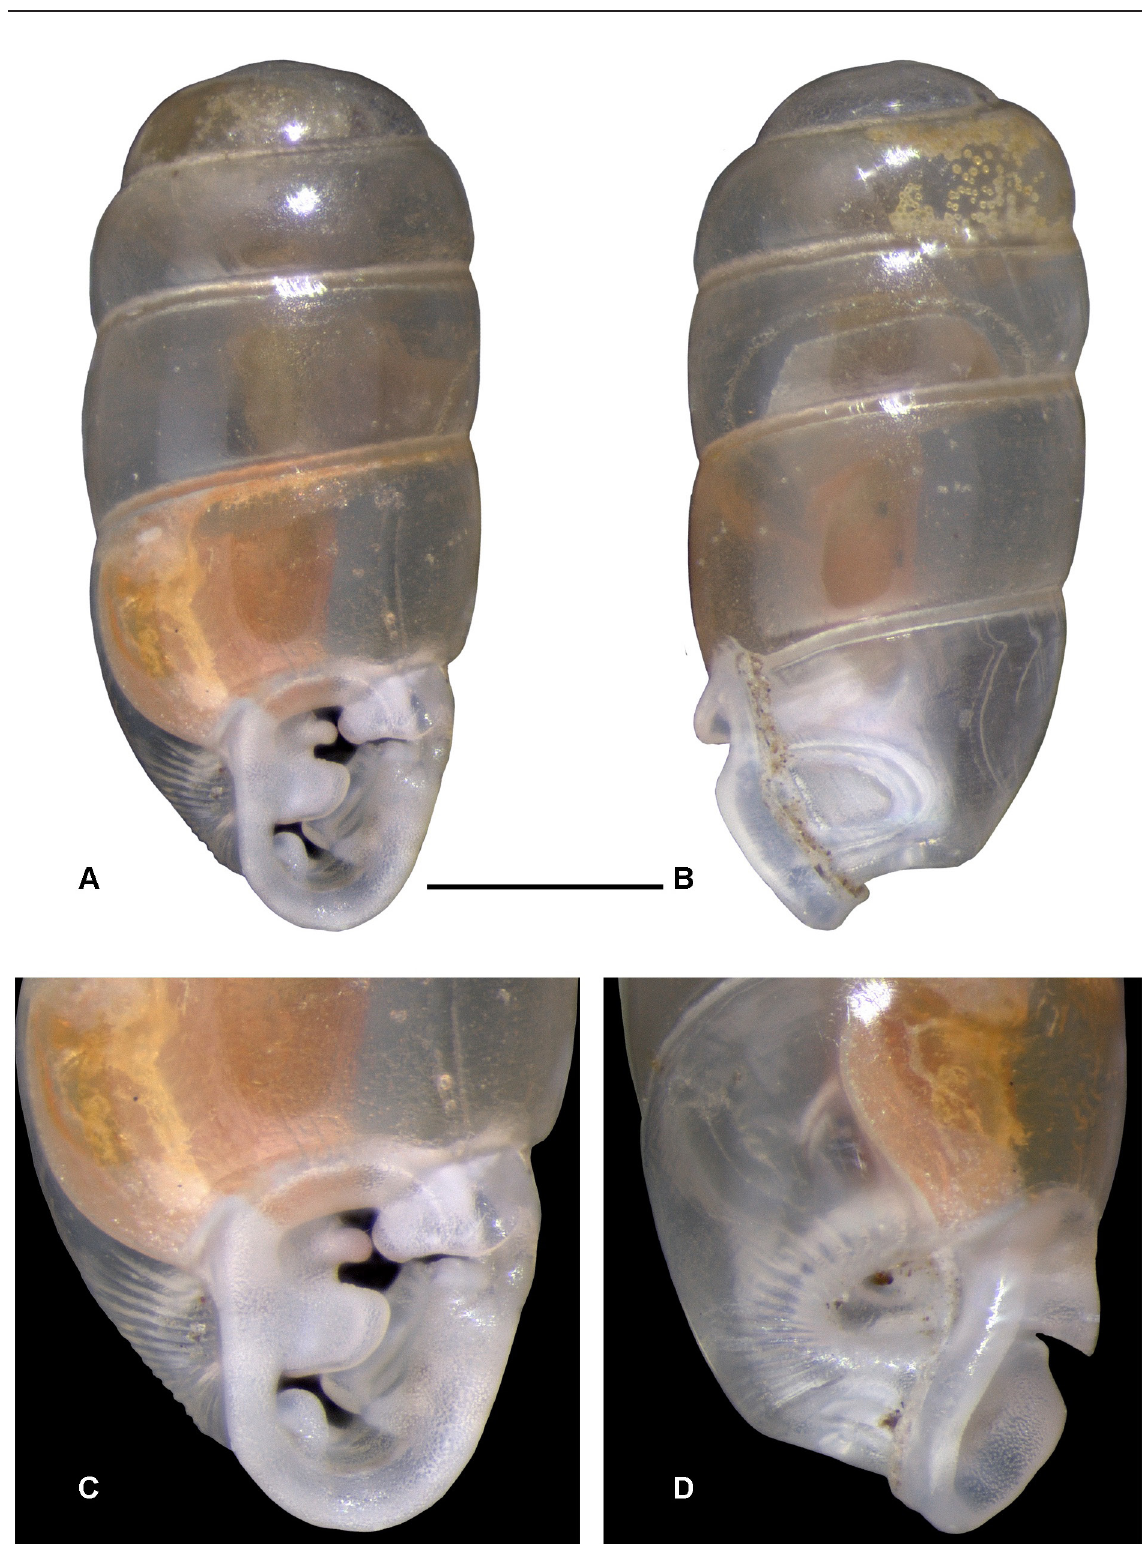
Fig. 5. Gulella donaikeni sp. nov., holotype (NMSA W9640/T4521), length 1.85 mm, width 0.84 mm. A . Aperture view. B . Side view. C . Oblique view into aperture. D . Oblique view of base showing umbilicus. Scale bar = 0.5